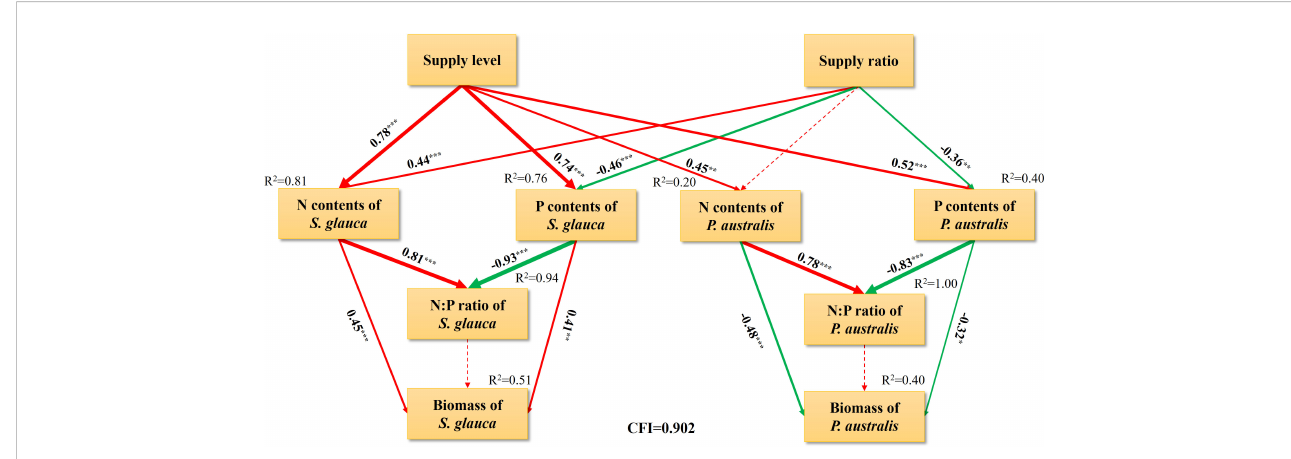
FIGURE 6 Structural equation model (SEM) considering the underlying causal relationships among leaf N and P contents, N:P ratio and biomass of S. glauca and P. australis under various N and P supplies. CFI, con fi rmatory fi t index. Bold and dashed lines indicate signi fi cant ( P <0.05) and nonsigni fi cant ( P >0.05) pathways, respectively. The width of arrows indicates the strength of the causal effect, while arrows colored red and green indicate positive and negative relationships respectively. The numbers listed within arrows are the standardized path coef fi cients. The R 2 values represent the proportion of the variance explained for each variable. Signi fi cance levels are as follows: * P < 0.05, ** P < 0.01, and *** P <